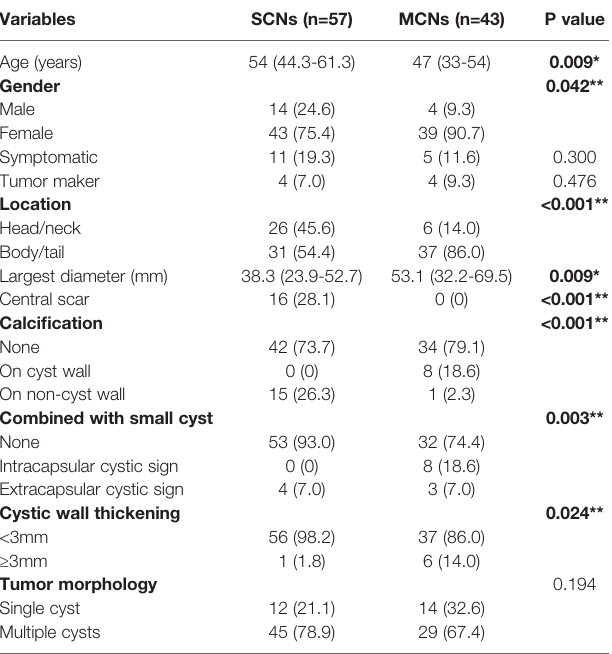
TABLE 1 | Comparison of the clinical information and imaging features between SCNs and MCNs. Variables SCNs